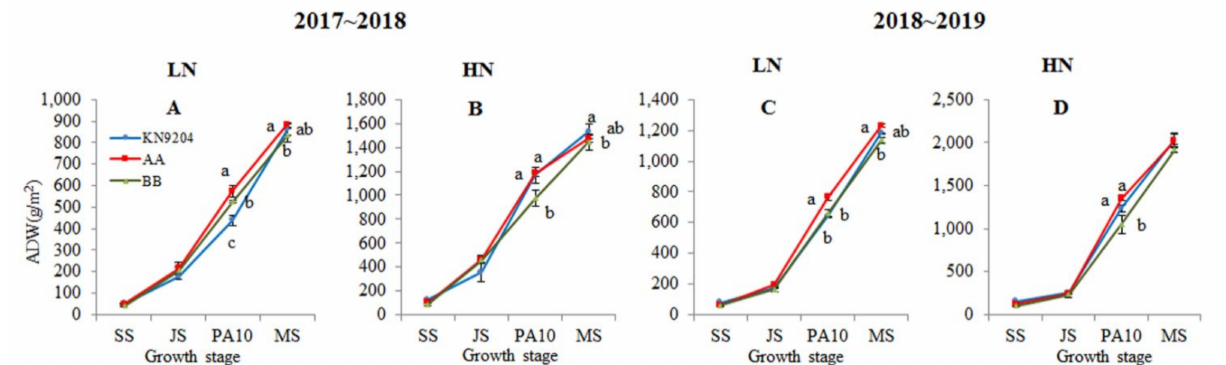
Figure 3. Aerial dry weight (ADW) of KN9204 and the QMrl-7B near isogenic lines (NILs) at different stages. 2017~2018 ( A , B ) and 2018~2019 ( C , D ) indicate growing seasons; LN ( A , C ) and HN ( B , D ) indicate low nitrogen and high nitrogen environments, respectively; AA indicates QMrl-7B NILs with the superior alleles; BB indicates QMrl-7B NILs with the inferior alleles; SS, JS, PA10 and MS indicate seedling stage, jointing stage, 10 days post anthesis and maturity, respectively; Different lowercases indicate significant differences ( p < 0.05) among the genotypes at the same growth